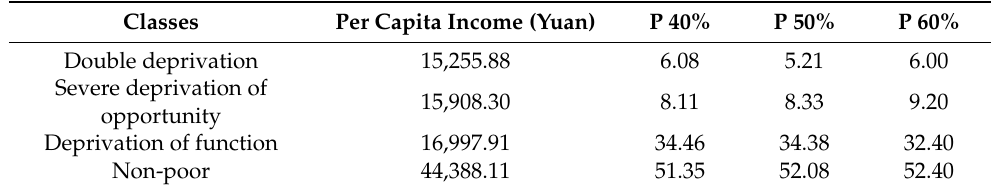
Table 6. Overlap rate of multiple deprivation categories and income poverty